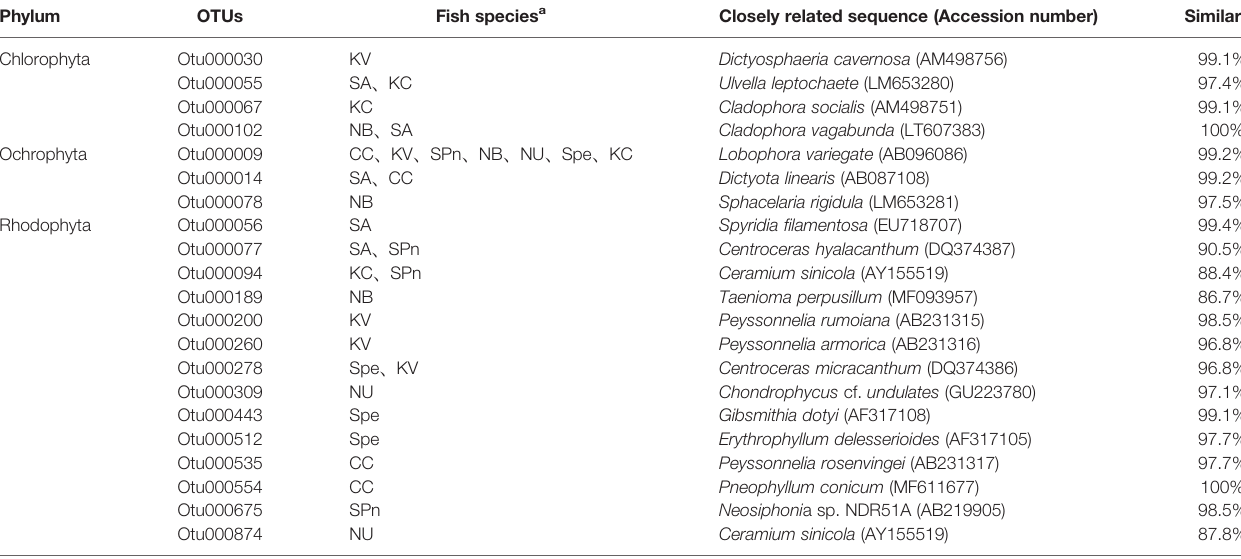
TABLE 3 | Taxonomicassignment of the dominant OTUsaf fi liated to the phyla Chlorophyta, Ochrophyta and Rhodophyta, found in fi sh intestines using BLAST methodologies. Phylum OTUs Fish species